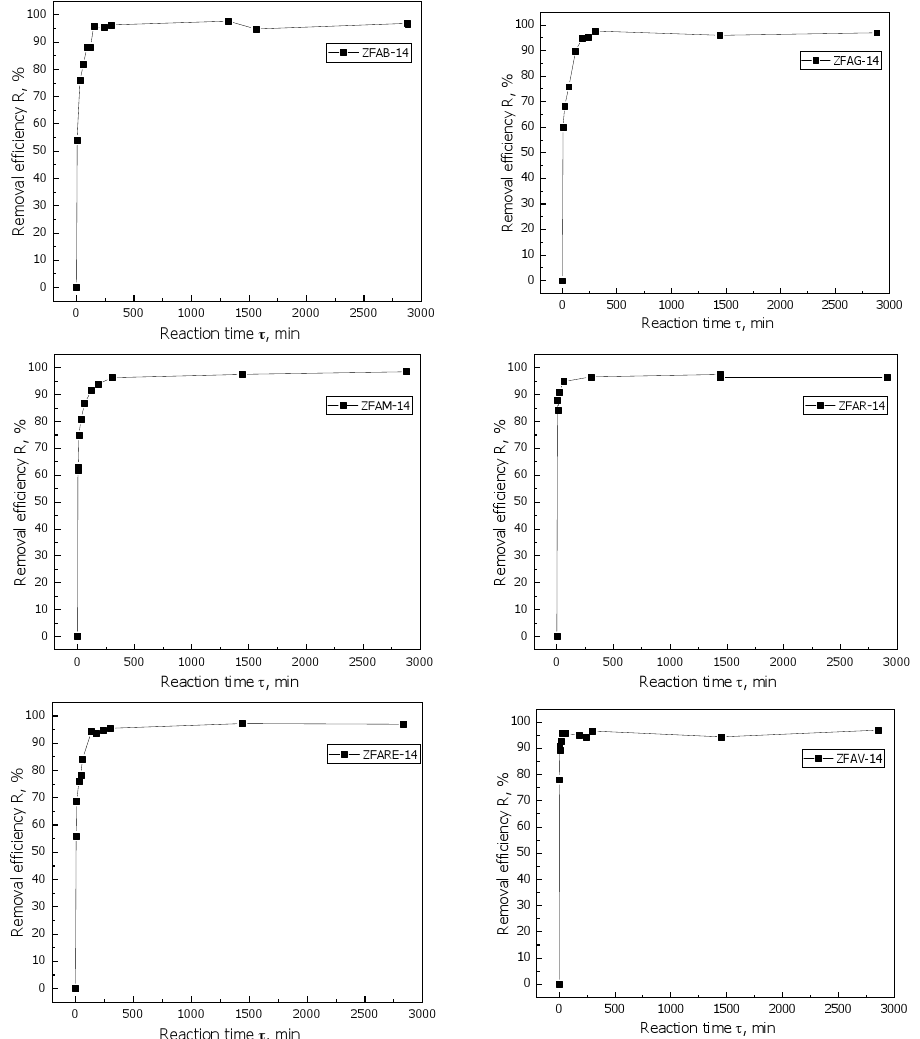
Figure 6. Adsorption kinetics of Malachite green onto the surface of synthetic fly ash zeolites obtained after 14 months of self-crystallization.